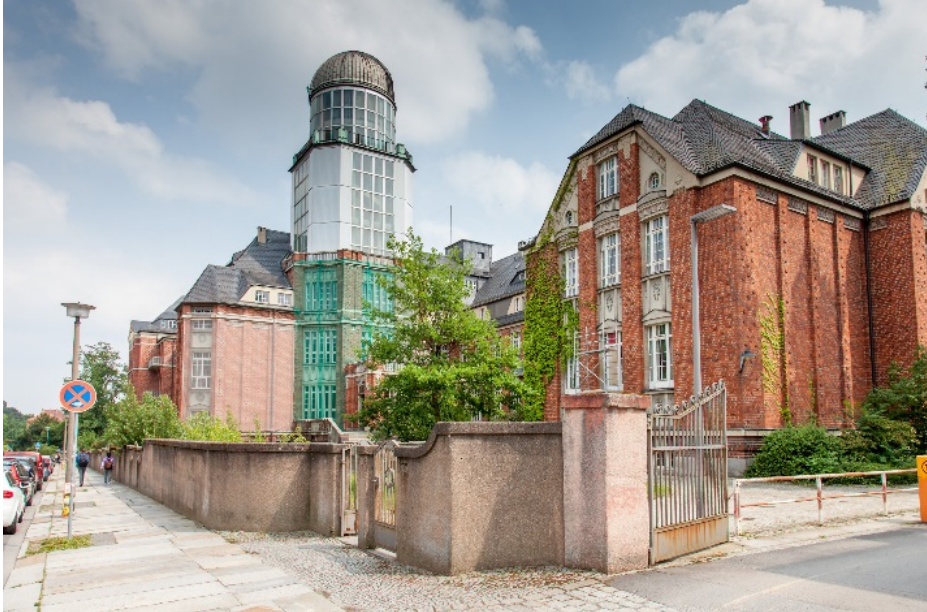
Figure 6. View of the Beyer Bau. (Photo: S. Gröschel).